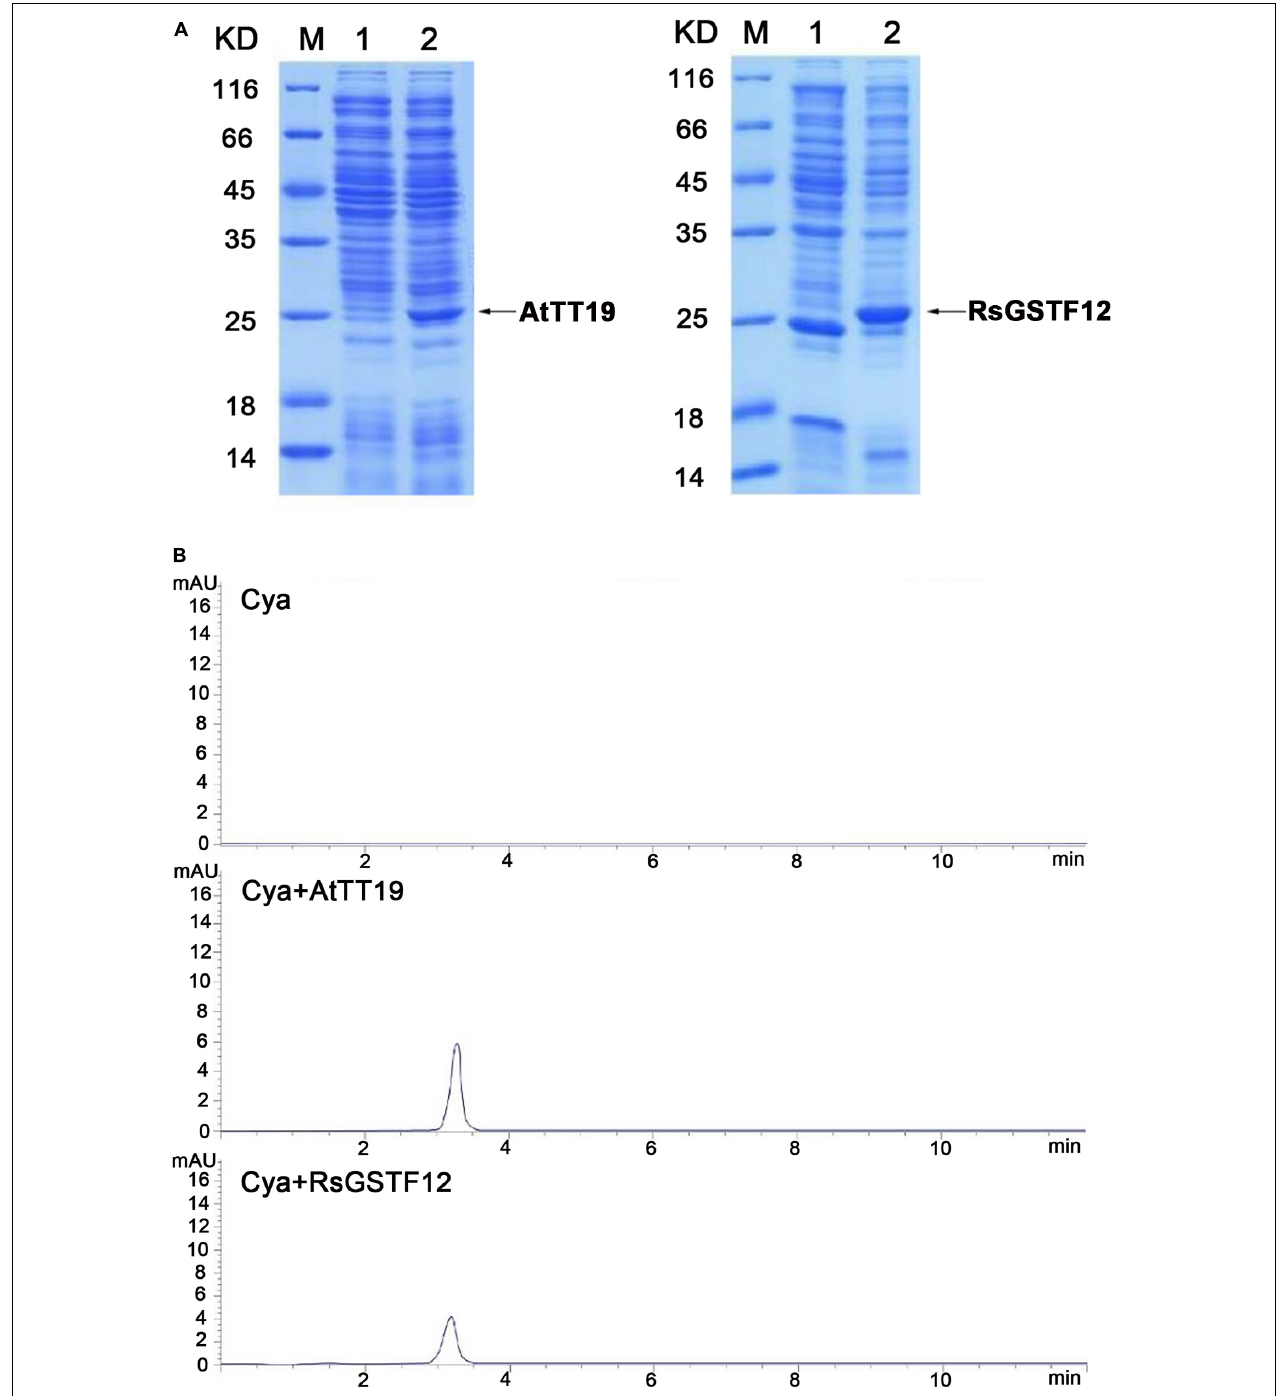
FIGURE 4 | RsGSTF12 combines with cyanidin in vitro . (A) SDS–PAGE analysis of AtTT19 and RsGSTF12. M, Protein molecular weight marker; 1, uninduced protein; 2, induced protein. (B) High-performance liquid chromatography (HPLC) analysis of cyanidin’s content when it was incubated with RsGSTF12 and AtTT19 for 120